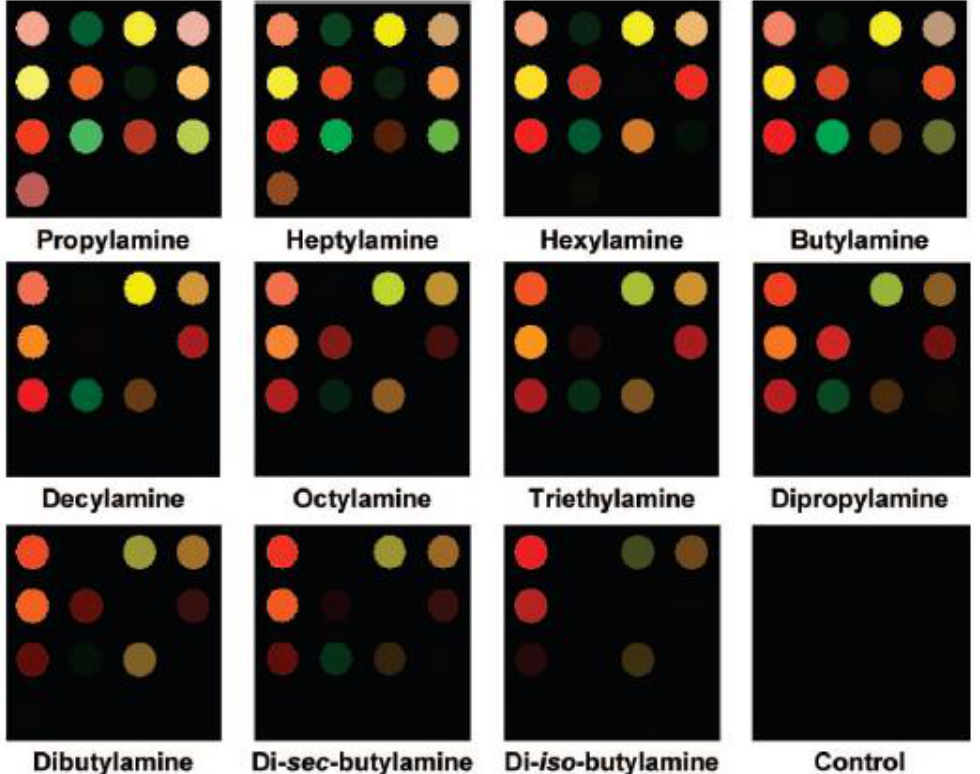
Figure 16. Color profiles of 11 similar aliphatic amines after equilibration with the aerosol-gel-based colorimetric sensor arrays [48].